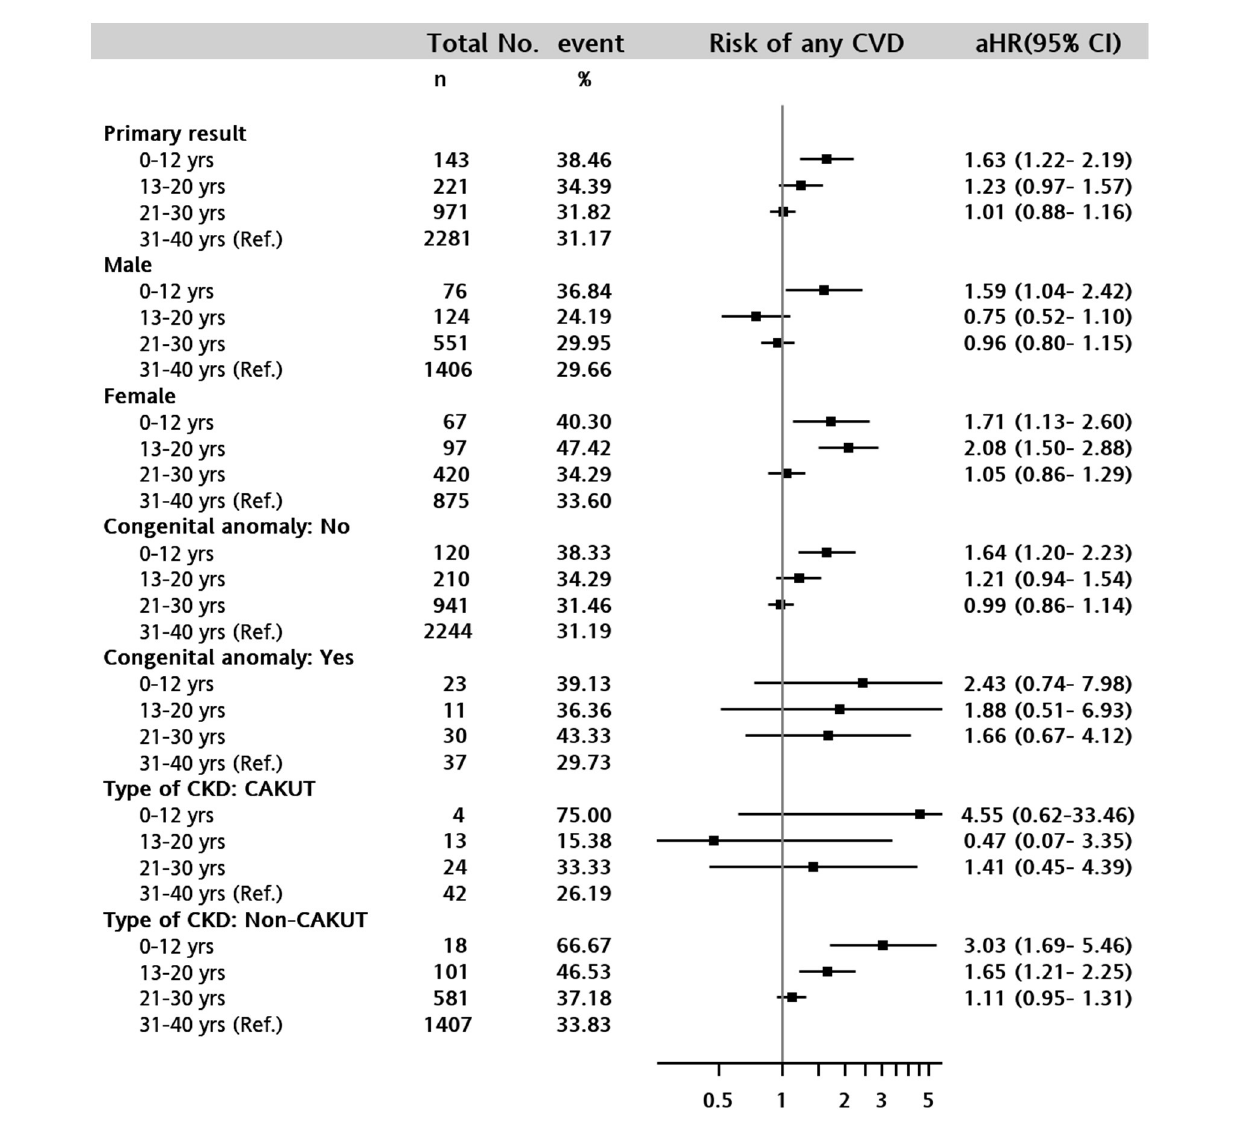
FIGURE2 Forest plot of adjusted hazard ratio for the composite cardiovascular disease event in 0–12 years, 13–20 years, 21–30 years, and 31–40 years (reference) of age groups. The following covariates were adjusted for in the death-censored Cox proportional hazards model: Sex, type of CKD (CAKUT, non-CAKUT, and non- CKD), any congenital anomalies, baseline comorbid conditions of liver disease, severe liver disease, diabetes with and without complications, cancer, metastatic cancer, hypertension, hyperlipidemia, and AKI